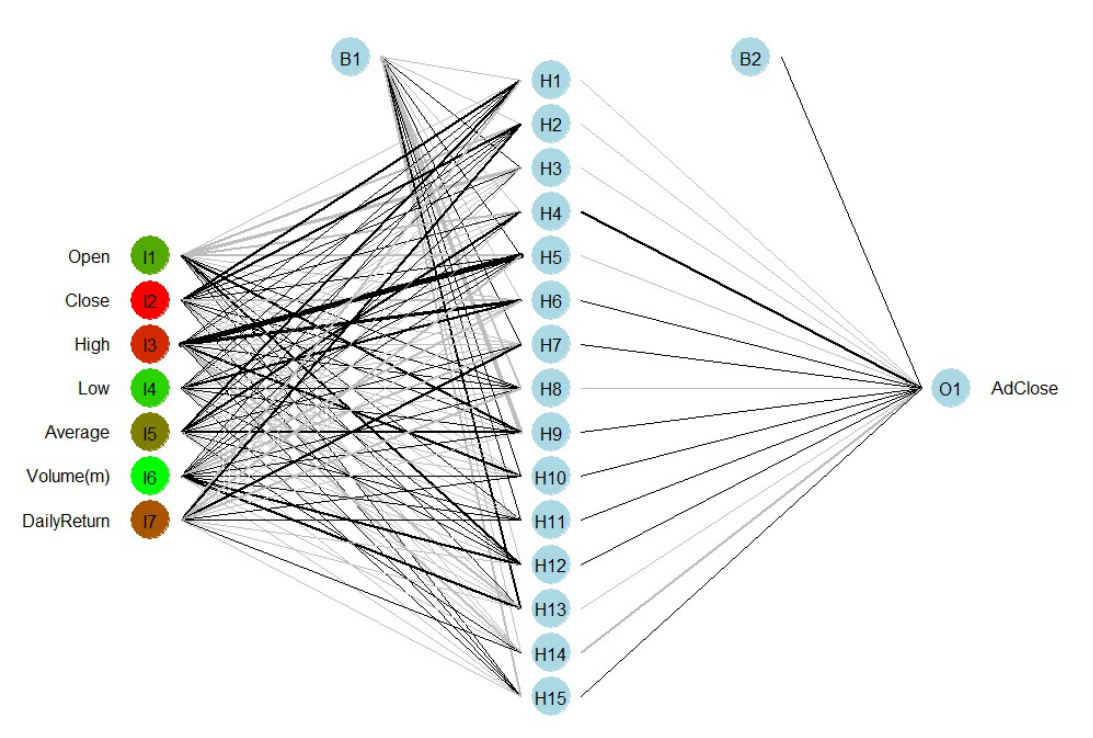
Figure 5. Artificial neural network